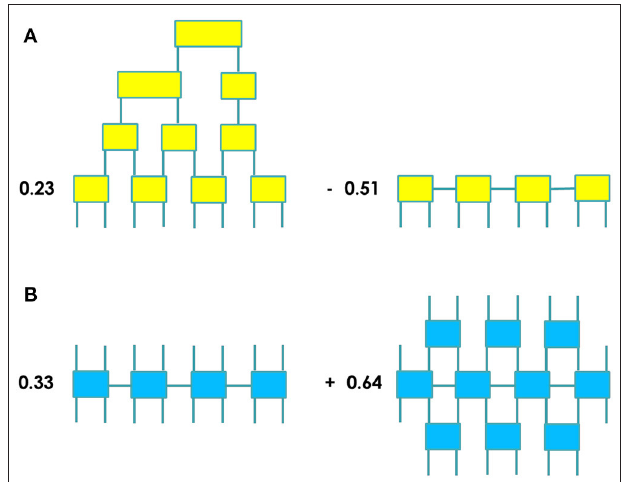
FIGURE 2 | (A) An example of a tensor network expansion as a linear combination of two tensor networks of the same order; (B) An example of a tensor network operator as a linear combination of two tensor networks with open legs establishing a map between the ket and bra